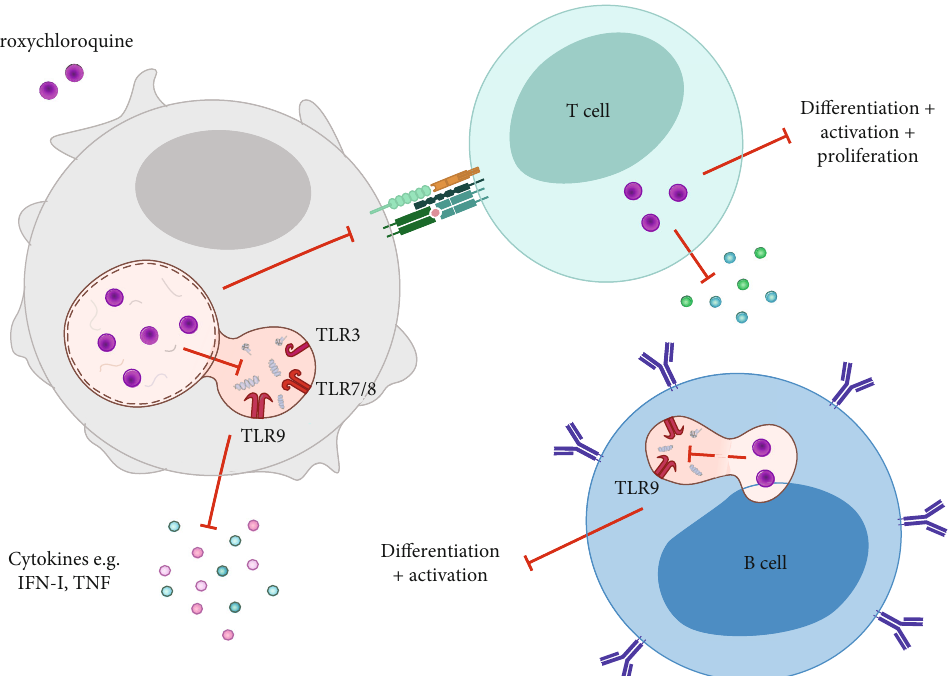
Figure 2: Immunosuppressive e ff ects of HCQ. Hydroxychloroquine a ff ects both the innate and adaptive immune system. By accumulating in the lysosome and autophagosome, the pH is increased causing an inhibition of MHC-II antigen presentation and subsequent T cell activation. In addition, HCQ accumulation abrogates viral recognition by endosomal TLRs, resulting in a decrease of the antiviral innate immune response (i.e., IFN-I production). Moreover, HCQ can also directly a ff ect the adaptive immune system through inhibition of T and B cell di ff erentiation and